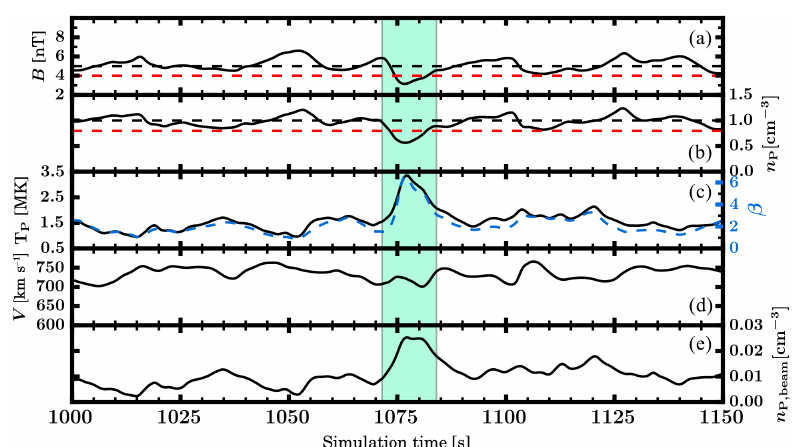
Figure 9. Time series of virtual spacecraft data extracted from the simulation domain at x = 0 R E , z = − 35 R E from t = 1000s to t = 1150s. The panels show, from (a) to (e) , the magnetic field magnitude, the proton density, the proton temperature (black) and the plasma β (blue), the solar wind bulk velocity, and the beam proton